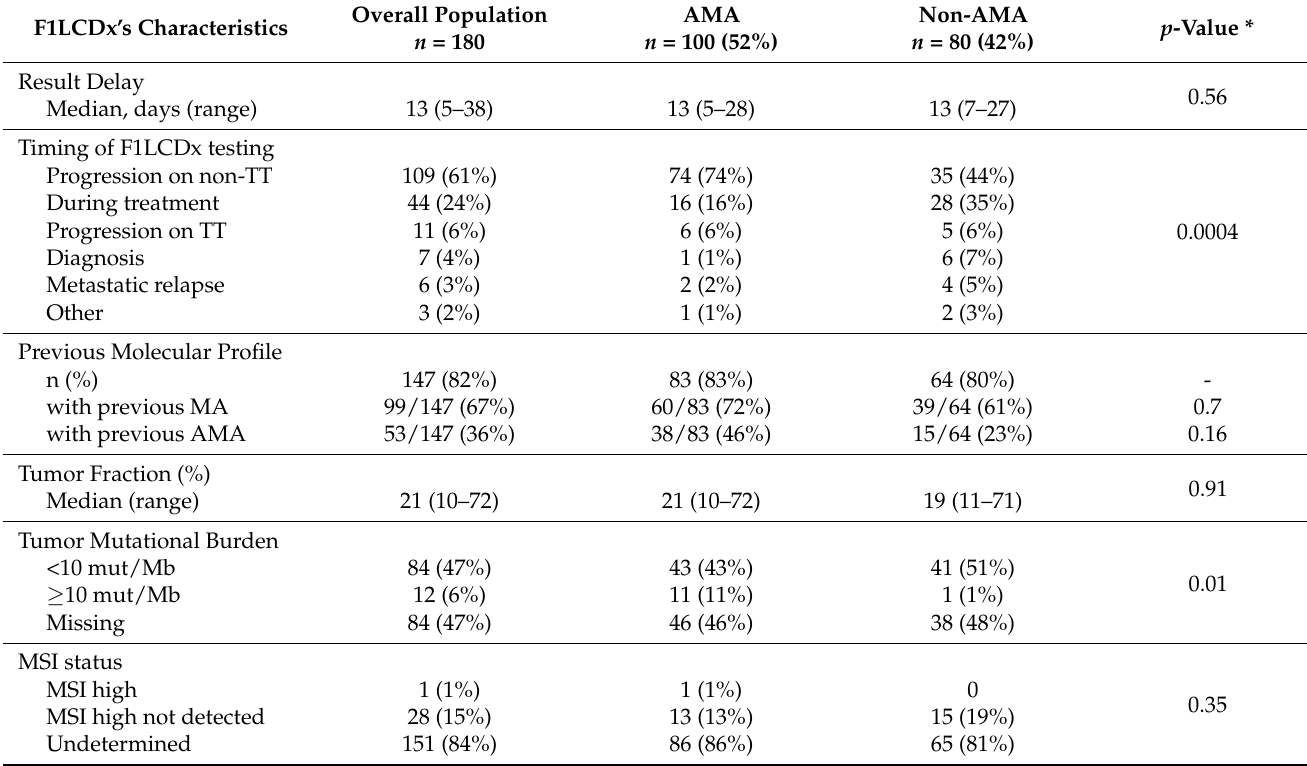
Table 2. Molecular profiling’s